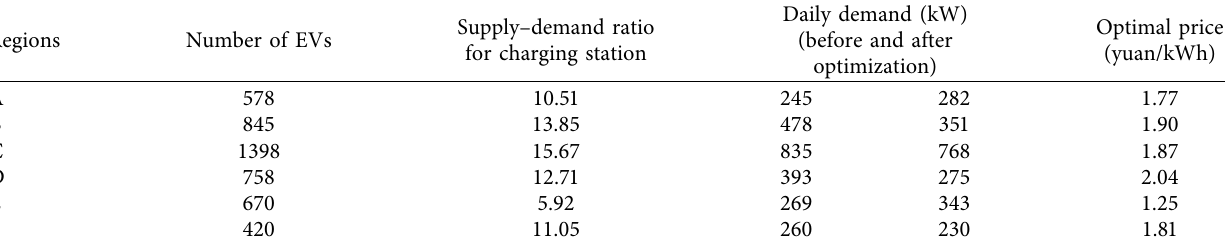
Table 1: Optimal pricing of electric vehicle charging in various regions of a city.